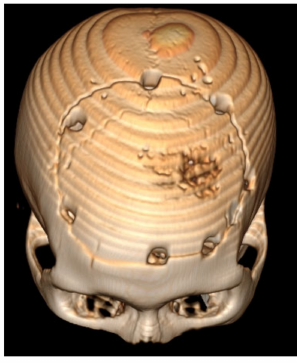
Figure 8. 3D recon of the